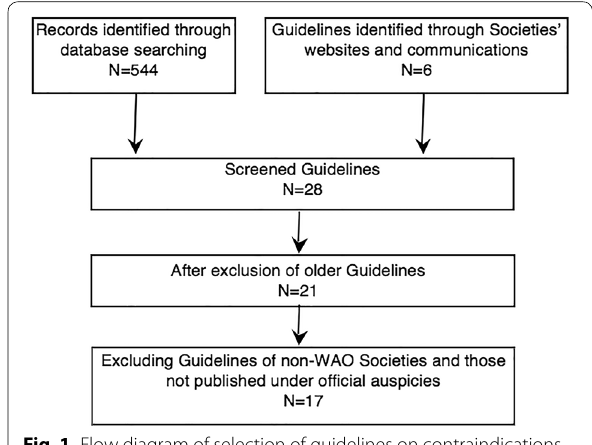
Fig. 1 Flow diagram of selection of guidelines on contraindications to